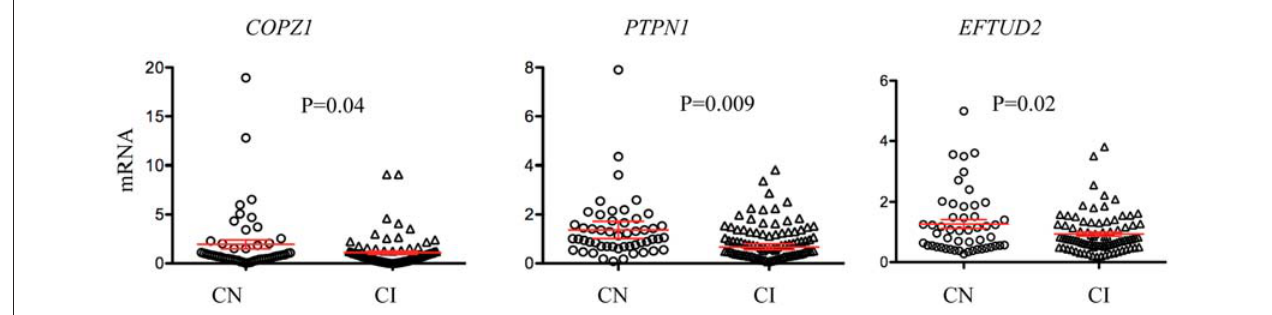
FIGURE 1 | RNA biomarkers associated with cognitive decline. Relative abundance of COPZ1 , PTPN1 and EFTUD2 was compared in subjects with normal cognition (CN = 51, circles) to cognitively impaired (CI = 87, triangles). Error bars represent the 95% confidence interval (CI). A p -value of less than 0.05 was regarded as significant based on a Student t -test